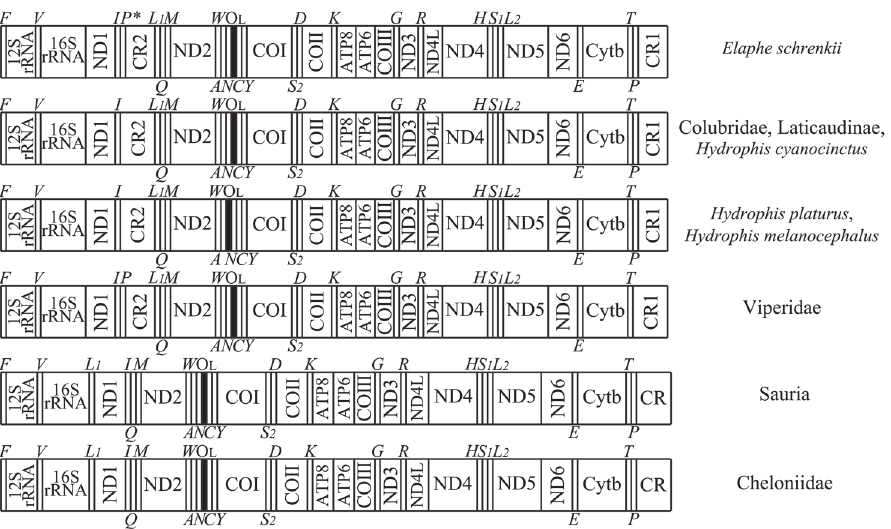
Figure 1. Comparison of the mitochondrial gene organisation for all 22 squamate species listed in South Korea. Two sea turtle species ( Caretta caretta and Chelonia mydas ), served as outgroups. L1 , L2 , S1 , S2 . P* represent the following genes: tRNA-Leu (UUR), tRNA-Leu (CUN), tRNA-Ser (AGY), tRNA-Ser (UCN) and a pseudo tRNA-Pro gene, respectively. tRNA genes are abbreviated by the corresponding one-letter amino acid codes, such as F , V , I , M